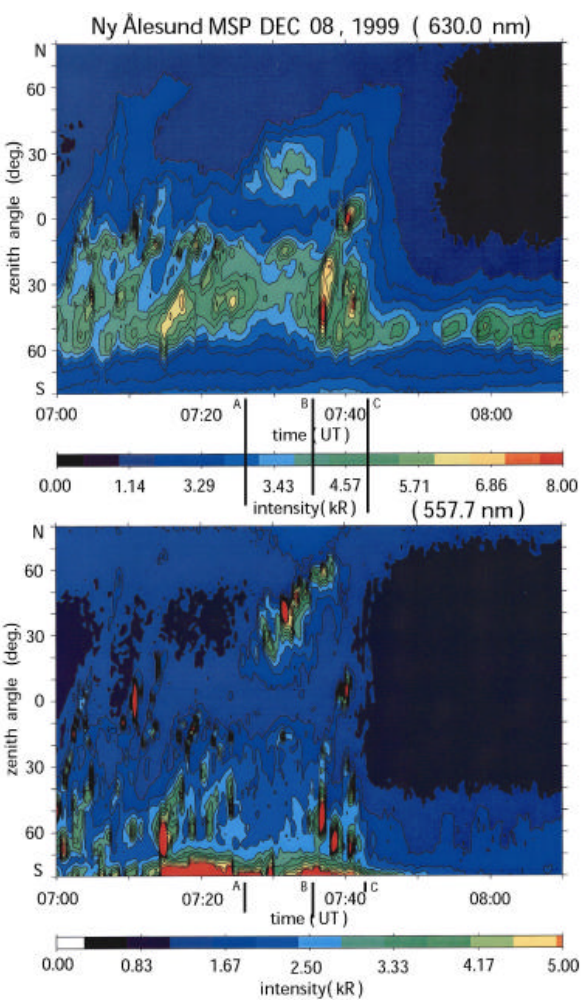
Figure 2 Fig. 2. MSP observations from Ny ˚Alesund: Auroral line of sight intensities versus zenith angle for the interval 07:00–08:10 UT. The auroral red (630.0nm) and green (557.7nm) lines are shown in the upper and lower panels, respectively. Intensity scales in kilo-Rayleighs (kRs) are given at the bottom of each panel. Times corresponding to specific features in the IMF, shown in Fig. 1, have been marked by vertical guidelines (A–C) in the figure. Intensity scale is given at the bottom of each